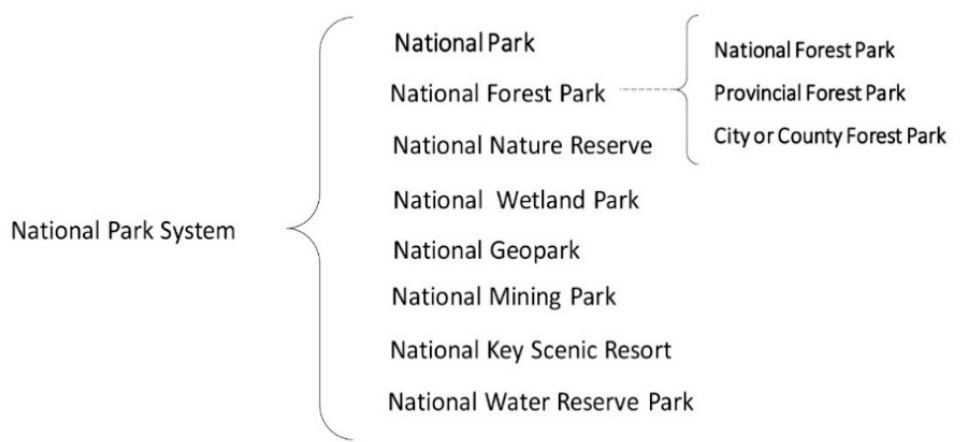
Figure 2. The position of NFPs in China’s National Park system. (Information collected from the document of National park management system).